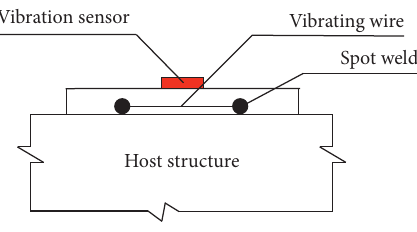
Figure 3: Vibrating-string sensor structure.